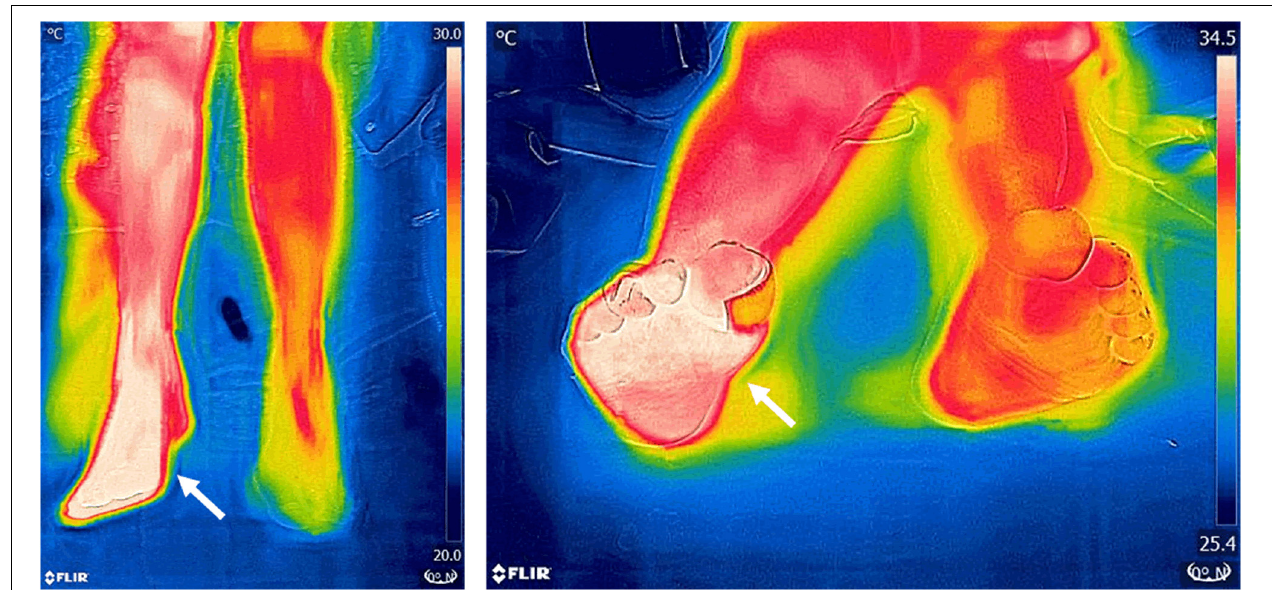
FIGURE 10 | Thermographic imaging of a patient after endovascular revascularization. Thermograms 24 h post-surgery of a patient with severe peripheral artery disease (PAD) who underwent endovascular revascularization show a positive gradient of temperature of 4.2 ◦ C compared to the non-revascularized limb. The hotspots (arrows) are highly predictive of a successful treatment. In this patient, reperfusion was confirmed angiographically during surgery and by Doppler ultrasound at follow-up. Images, courtesy of JA-C, were acquired using a FLIR One Pro mobile